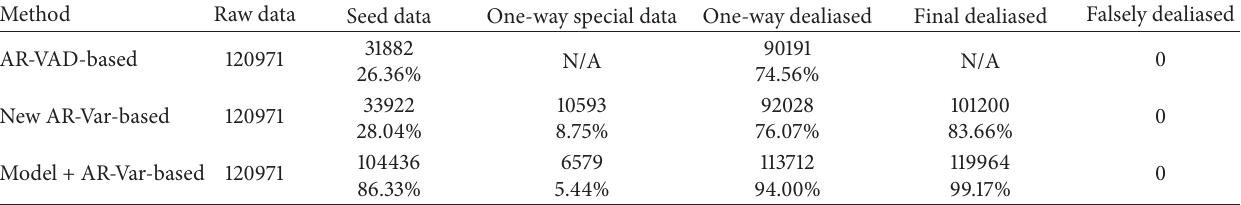
Table 1: Numbers of raw data (column 2), seed data (column 3), one-way special data (column 4), one-way dealiased data (column 5), final dealiased data (column 6), and falsely dealiased data (column 7) are produced by the three methods (column 1) for the case in Figure 2. The percentage with respect to the total number of raw data is also listed below the number in each type of data in the same box. “Seed data” are dealiaseddataproducedbythereferencecheckalone.“One-wayspecialdata”arespecialdataidentifiedbythefirstone-wayforwardprocedure (see the flowchart in Figure 3(b)) in the continuity check. “One-way dealiased” data are dealiased data produced by the first one-way forward